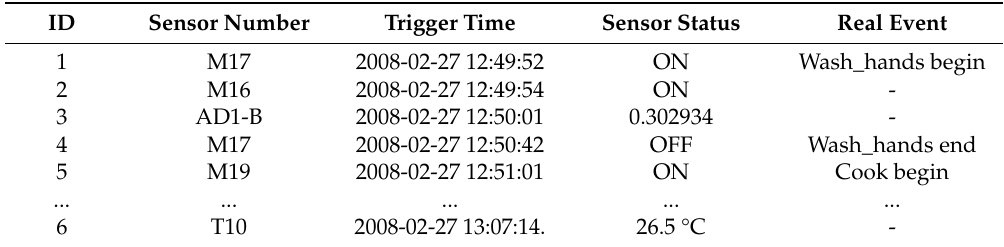
Table 1. Examples of the